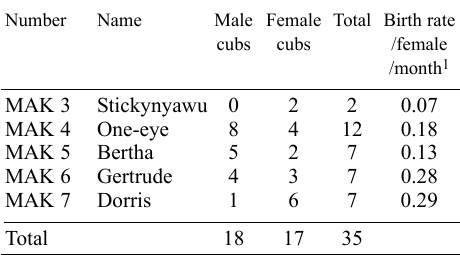
Table 2 Number of cubs born to each female on